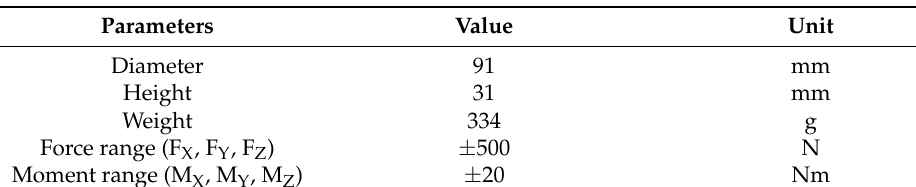
Table 1. Structural design specification.